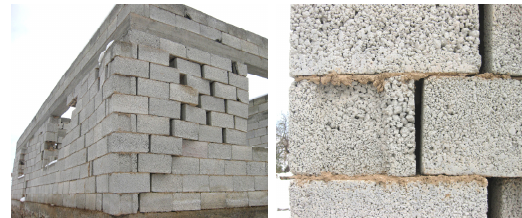
Fig. 14. Wall damage due to low strength joint adhesive.